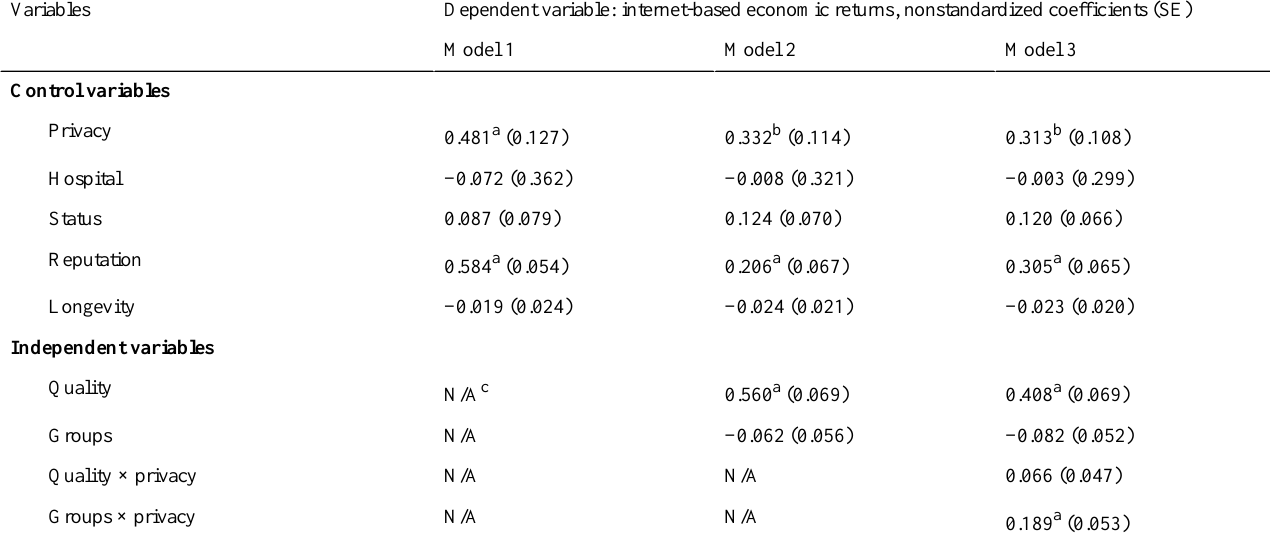
Table 3. Regression analysis. Dependent variable: internet-based economic returns, nonstandardized coefficients